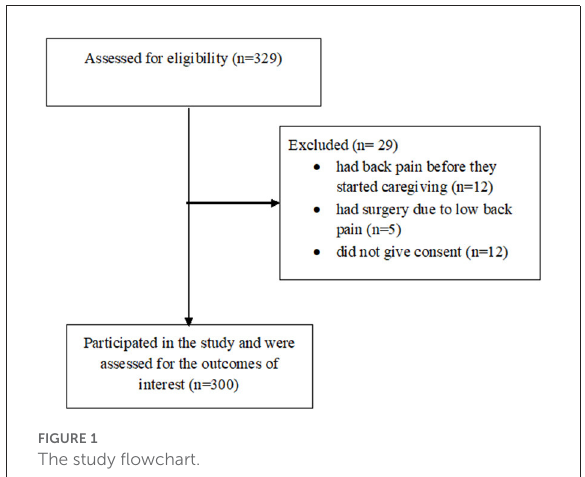
FIGURE1 The study